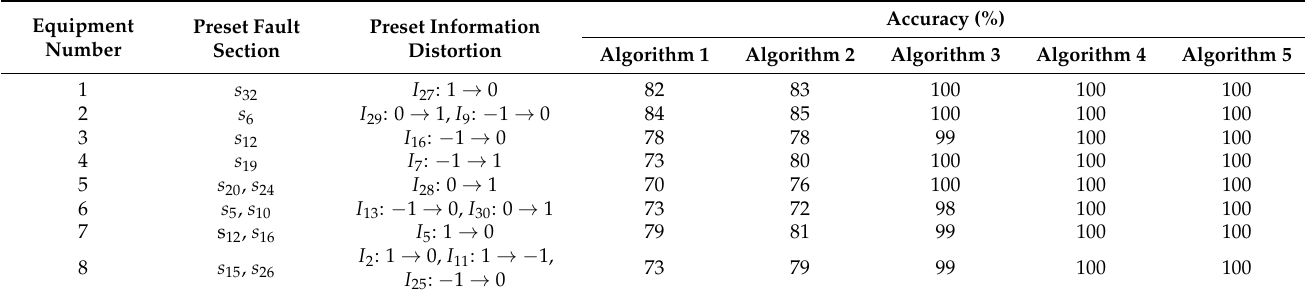
Table 6. Fault Tolerance results.